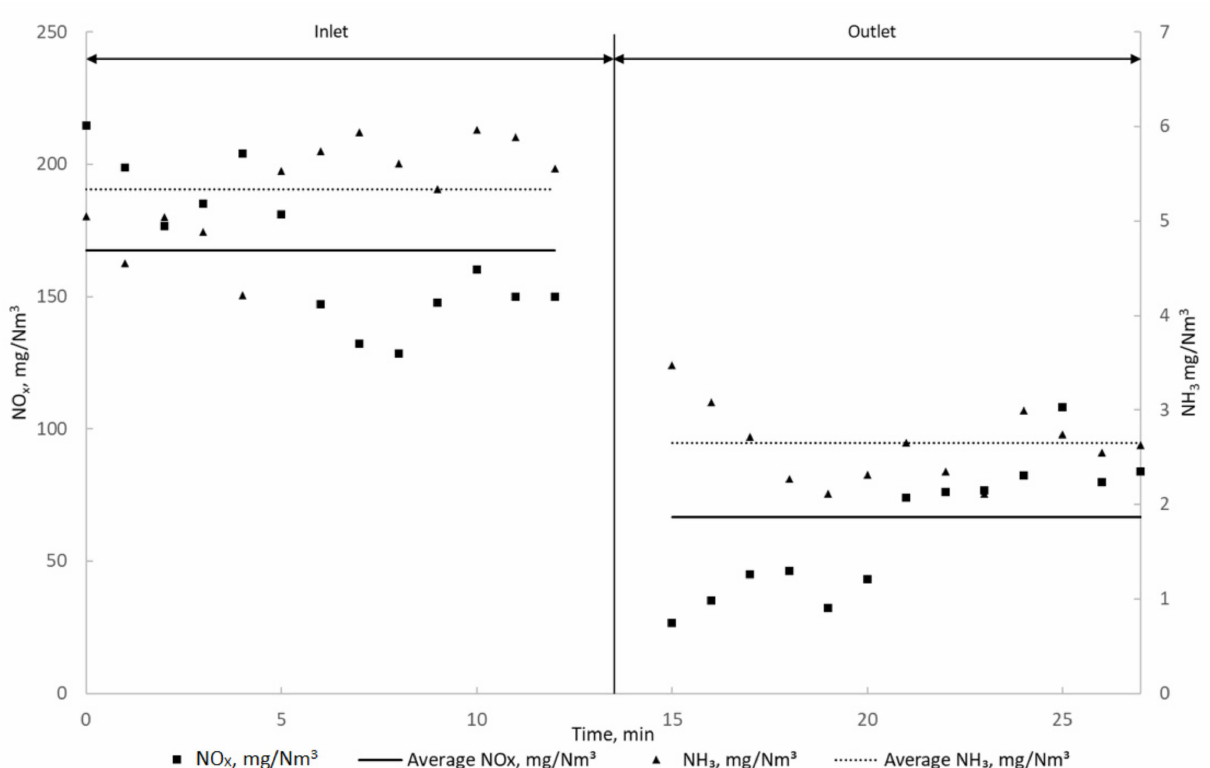
Figure 10. Emissions measured at the inlet and outlet of the new catalyst CN at an average power of 28 MW th -flue gas temperature approx. 400 ◦